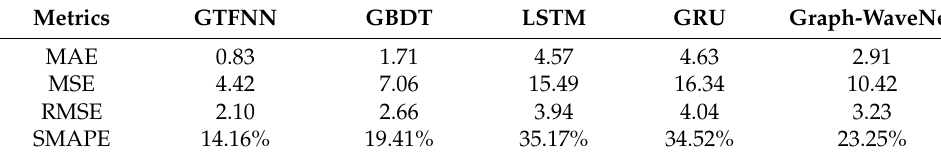
Table 6. The mean performances of models in forecasting weekdays OD flow.